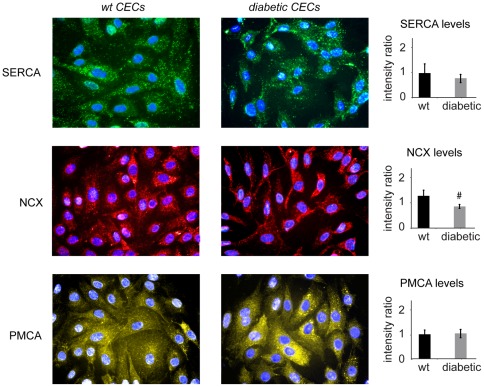
Diabetes results in decreased NCX protein expression, with no difference in SERCA and PMCA expression levels.Semi-quantitative analysis of immunofluorescent staining of CECs showed that diabetes significantly reduces the expression levels of NCX protein as compared to wild-type (NCX: red; blue: cell nuclei, #: p<0.05). No significant difference in the expression levels of SERCA and PMCA was observed in diabetic cells as compared to wild-type (SERCA: green; PMCA: yellow; blue: cell nuclei).